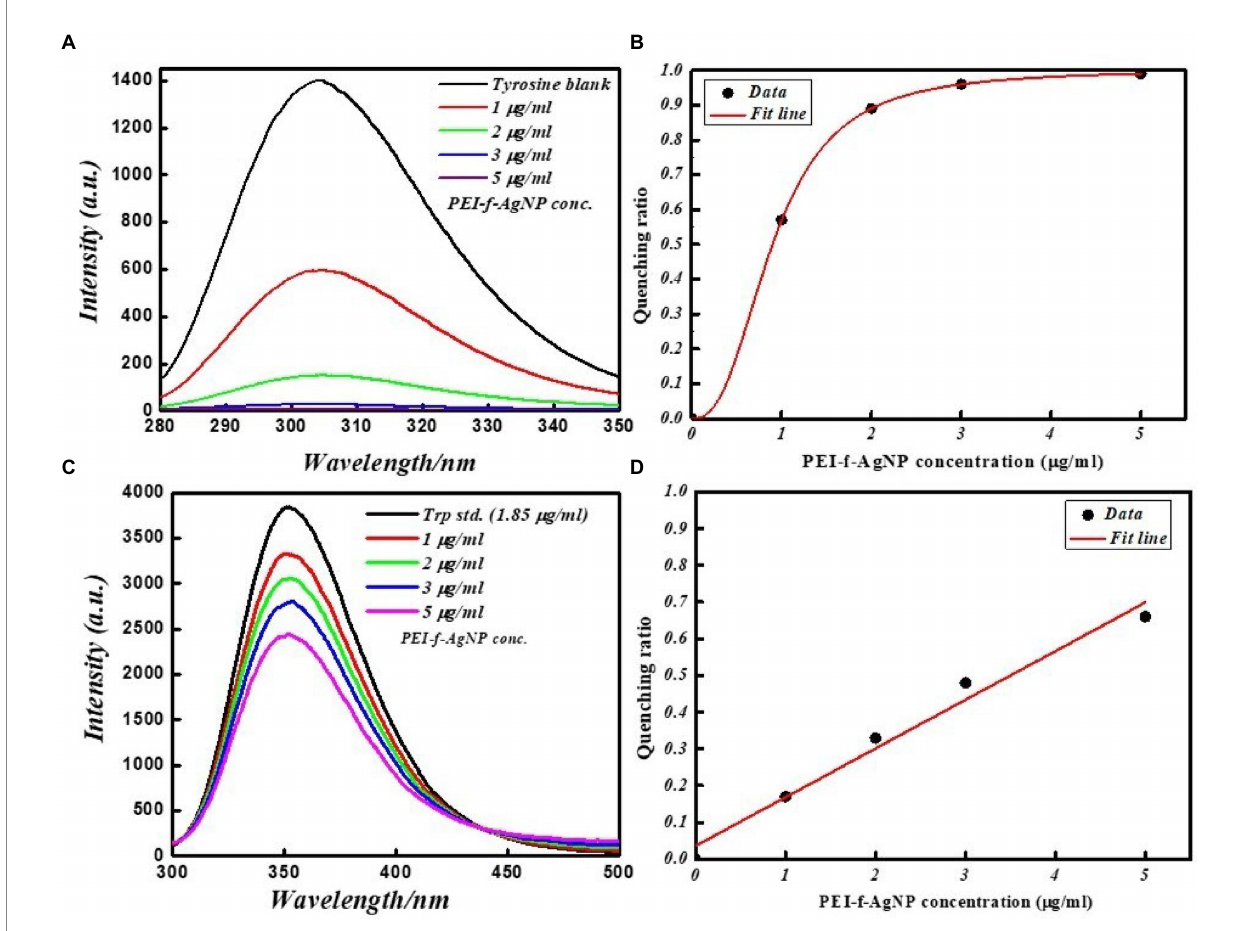
FIGURE 7 FL emission spectra of tyrosine and tryptophan amino acid standards at various concentrations with and without PEI-f-Ag-NPs: (A) fluorescence emission spectrum of tyrosine, (B) FL quenching ratio by PEI-f-Ag-NPs of tyrosine at various concentrations, (C) FL emission spectra of tryptophan at various concentrations of PEI-f-Ag-NPs, and (D) FL quenching ratio at various PEI-f-Ag-NPs concentration.